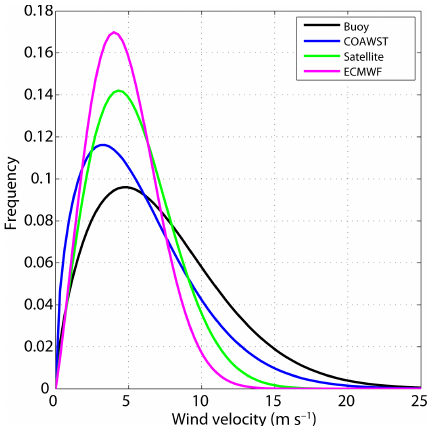
Figure 4. Weibull distribution adjustment for the wind velocities regarding the duration for the entire 12 months